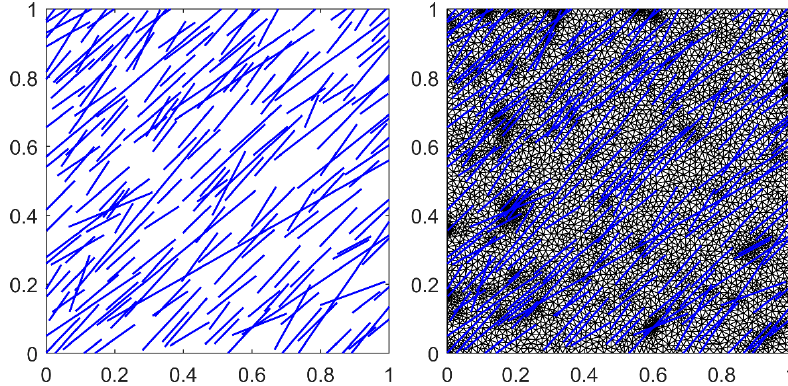
Figure 3. Discrete fracture network ( left ) and unstructured triangular mesh with 11,448 elements conforming to the fracture geometries ( right ).